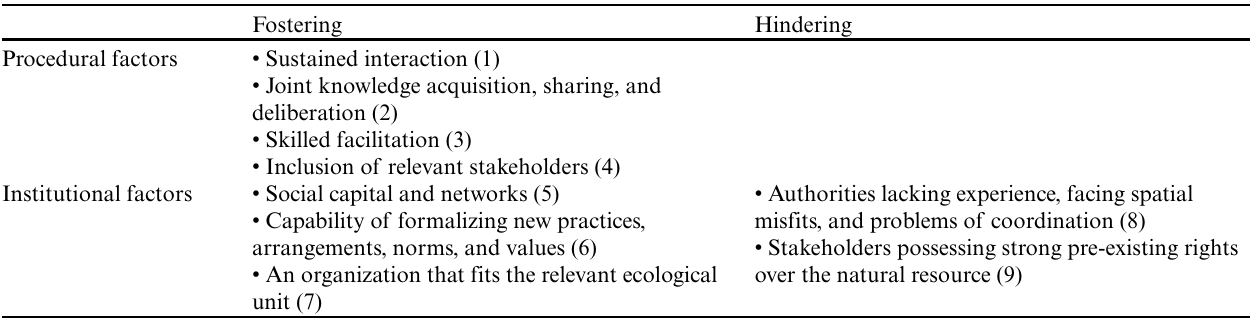
Table 1 . Research framework identifying procedural and institutional fostering and hindering factors of social learning that will be applied to the Ljusnan